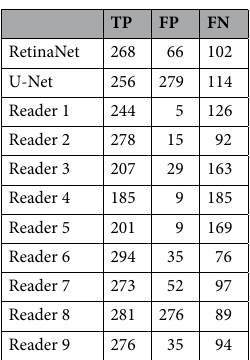
Table 1. True positives (TP), false positives (FP) and true negatives (FN) for RetinaNet, U-Net and the readers. For RetinaNet a nodule with a confidence score greater than 0.5 was counted as